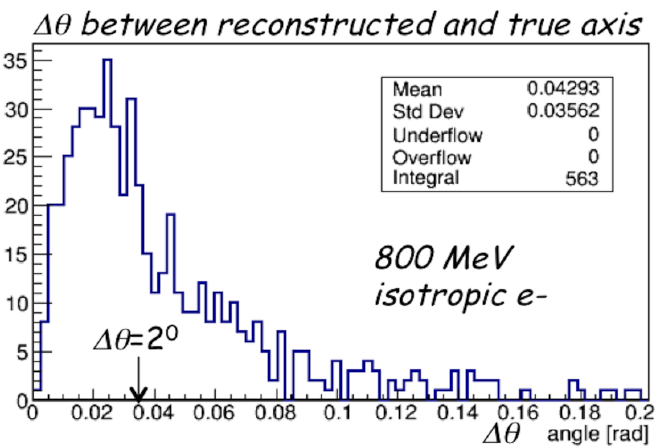
Figure 8. Preliminary results on the reconstruction of the direction of an electron shower with 800 MeV of deposited energy: in particular, the distribution of the angle between the real initial direction of the shower and the reconstructed direction is